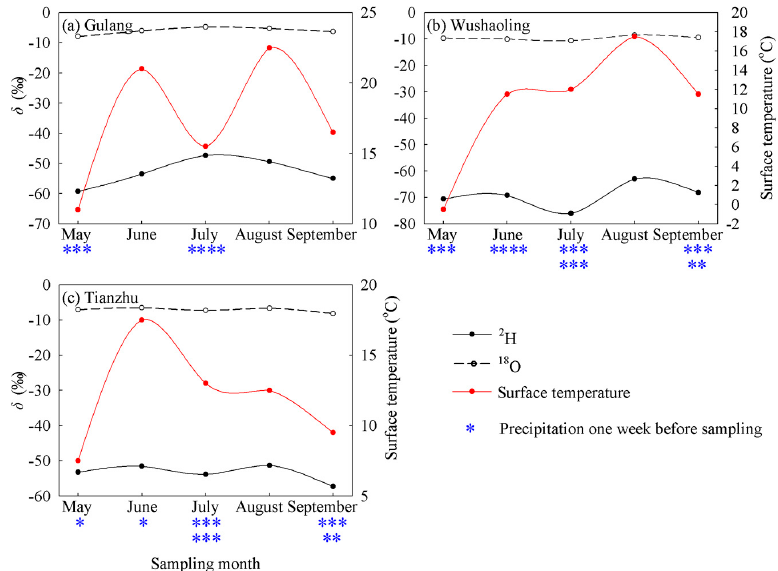
Figure 3. Mean δ 18 O, δ 2 H, and soil water content (SWC) for soil water at a depth of 0-100 cm in Gulang ( a , b , c ), Wushaoling ( d , e , f ) and Tianzhu ( g , h , i ). ( a – c ), Wushaoling ( d – f ) and Tianzhu ( g – i ).